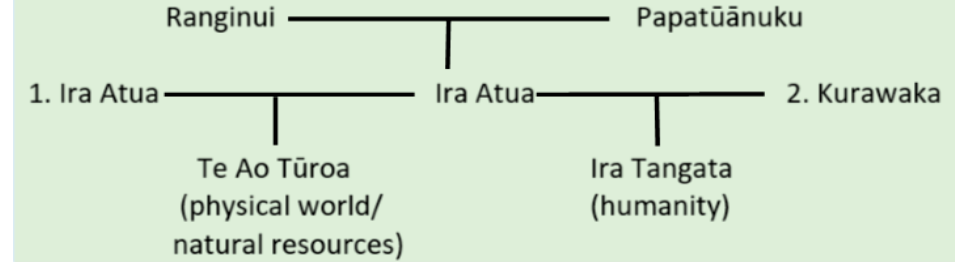
Figure 3. Whakapapa sequence representing the genealogical narrative of the primordial family.